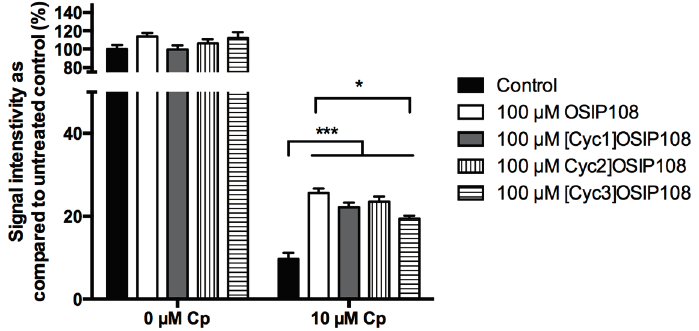
Figure 6. OSIP108 variants increase HepG2 tolerance to Cp. HepG2 cells were incubated with control (1% DMSO, black bars) or 100 µM OSIP108 (white bars), [Cyc1]OSIP108 (grey bars), [Cyc2]OSIP108 (vertical dashed bars) or [Cyc3]OSIP108 (horizontal dashed bars) in absence (0 µM Cp) or presence of 10 µM Cp. Following 72 h of incubation, cell proliferation was determined by BrdU assay and expressed as signal intensity as compared to untreated control. Technical repeats is three. ( * p < 0.05; *** p < 0.001; ANOVA test using Tukey